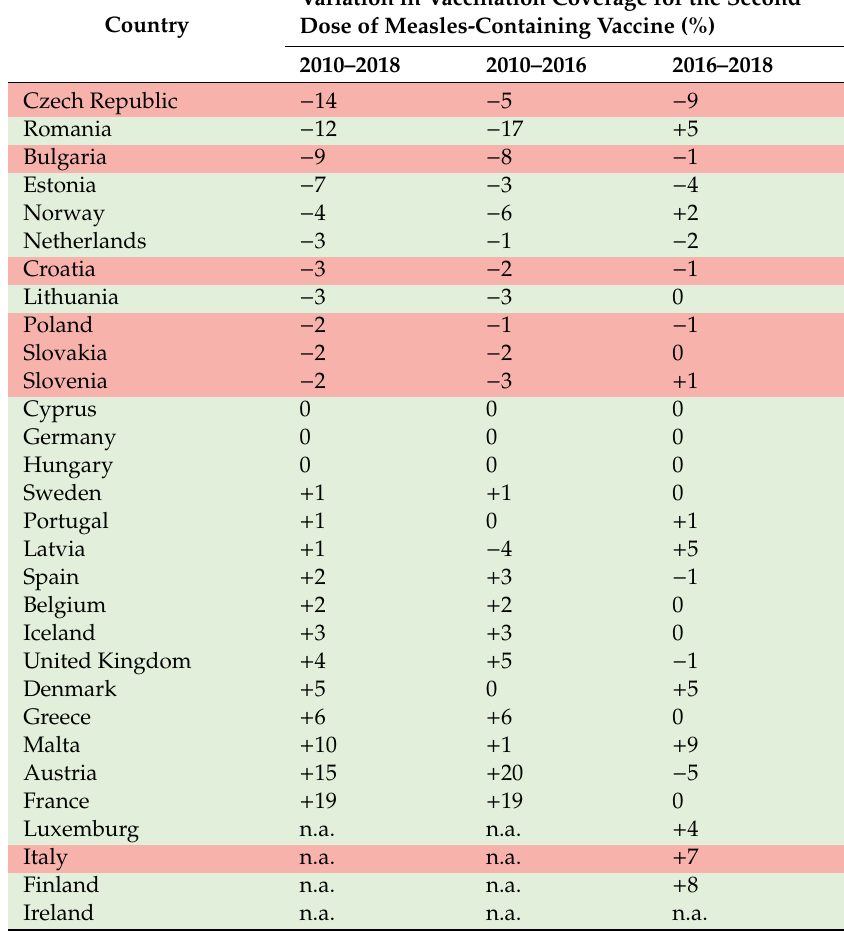
Table 2. Variation in vaccination coverage for the second dose of measles-containing vaccine between 2010 and 2018, 2010 and 2016 and 2016 and 2018. Variation in Vaccination Coverage for the Second Country Dose of Measles-Containing Vaccine